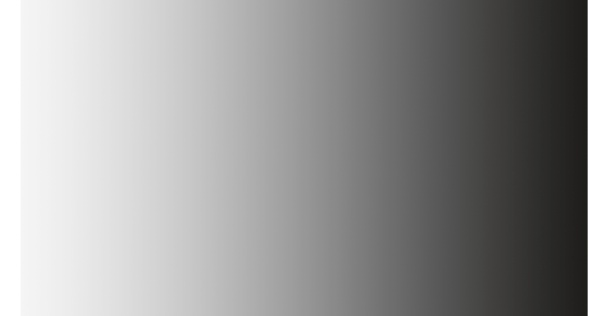
Figure 9: Unwrapped phase map of a plane that is retrieved from four fringe patterns projected by using four identical sinusoidal gratings and four diode lasers emitting at 790, 810, 850, and 910 nm. without the object at the following values of the system parameters: L = 0 . 025cm, λ 1 = 790nm, λ 2 = 810nm, λ 3 = 850nm, λ = 910nm, in addition to 512 pixels along 4